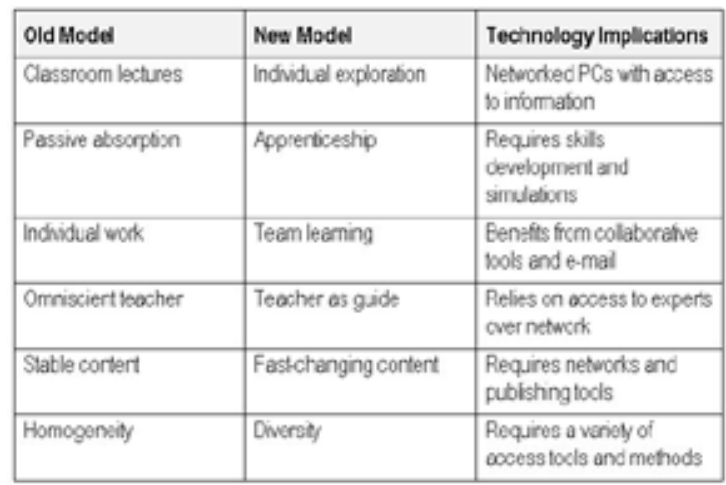
The old and new paradigms of